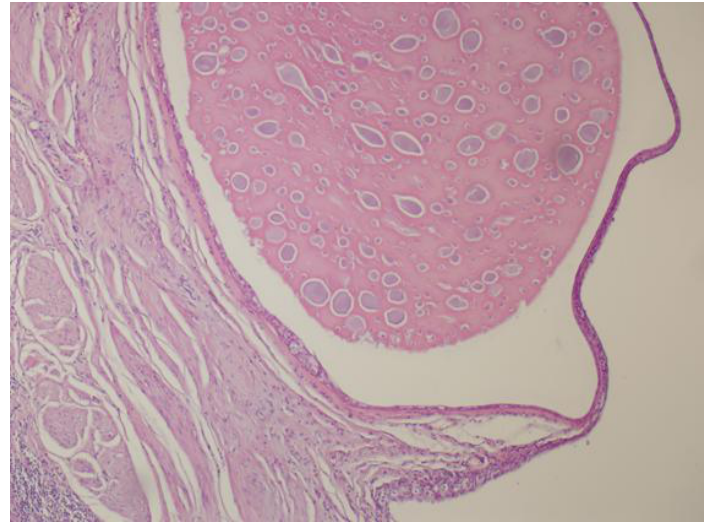
FIGURE 4. The cysts’ lumens were filled with a colloid like